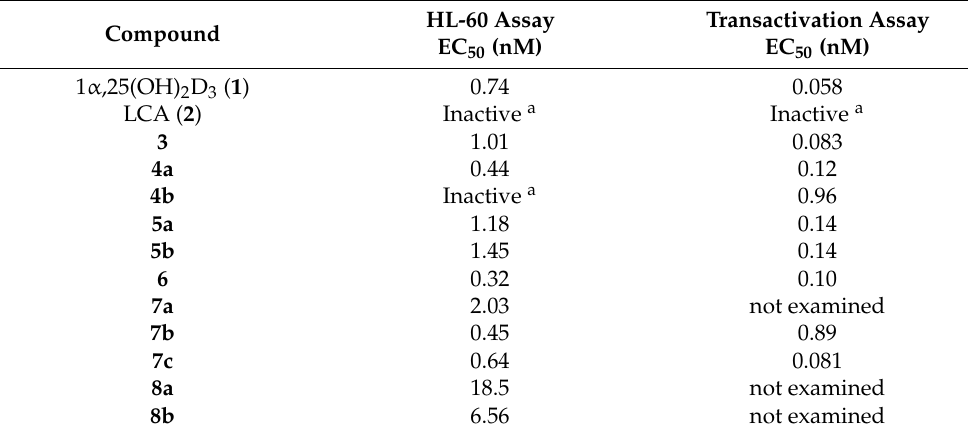
Table 1. EC 50 vales of novel lithocholic acid amide